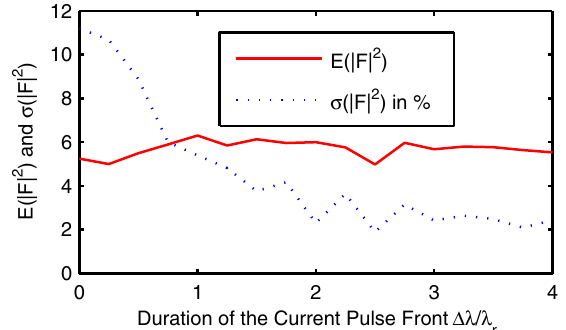
FIG. 11. The time-bandwidth product vs undulator distance. There is no shot noise in the